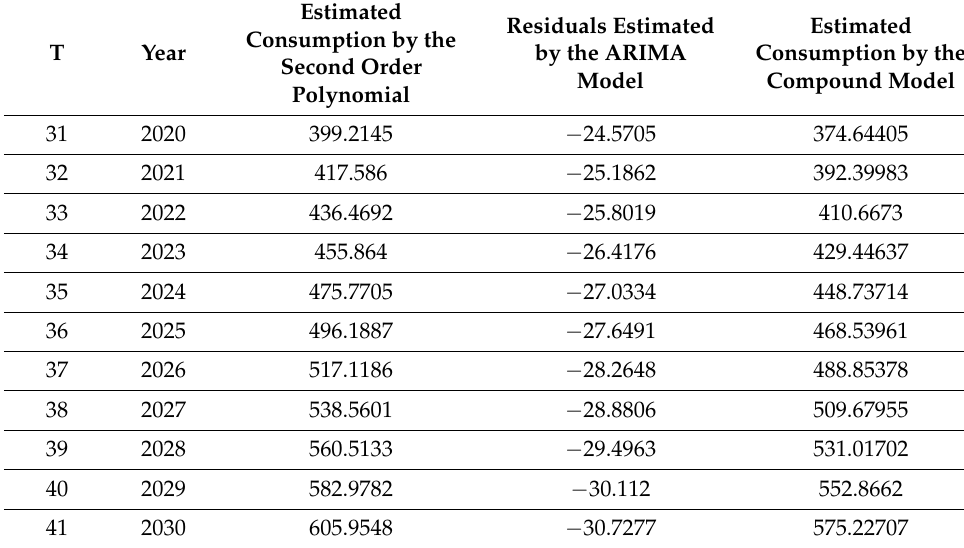
Table 1. Electricity consumption prediction values for the period 2020 – 2030.